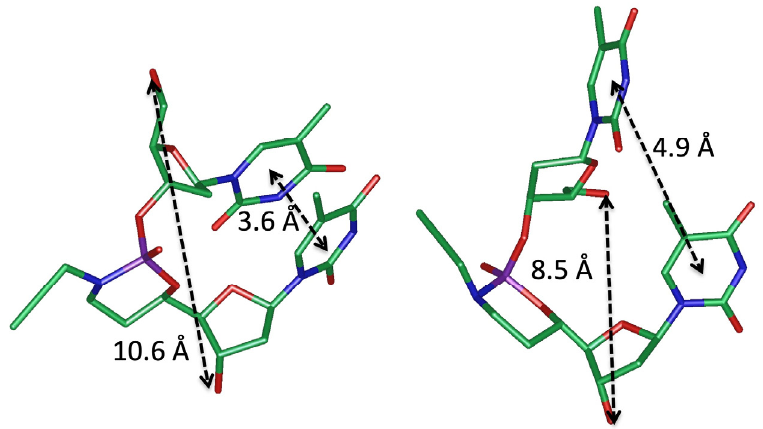
Figure 13. Lowest energy conformations from the in silico protocols. Left: ( R C5’ , R P )- α , β -C 2 NA. Right: ( S C5’ , S P )- α , β -D-C 2 NA.